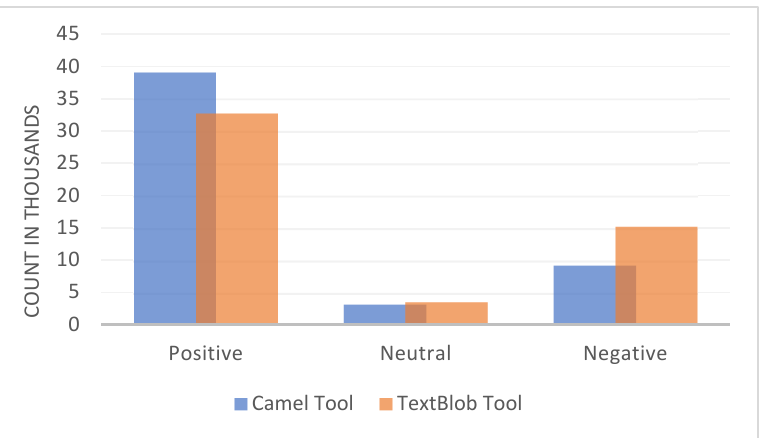
Figure 4. Comparison between sentiment ratio obtained by using the Camel tool and TextBlob.